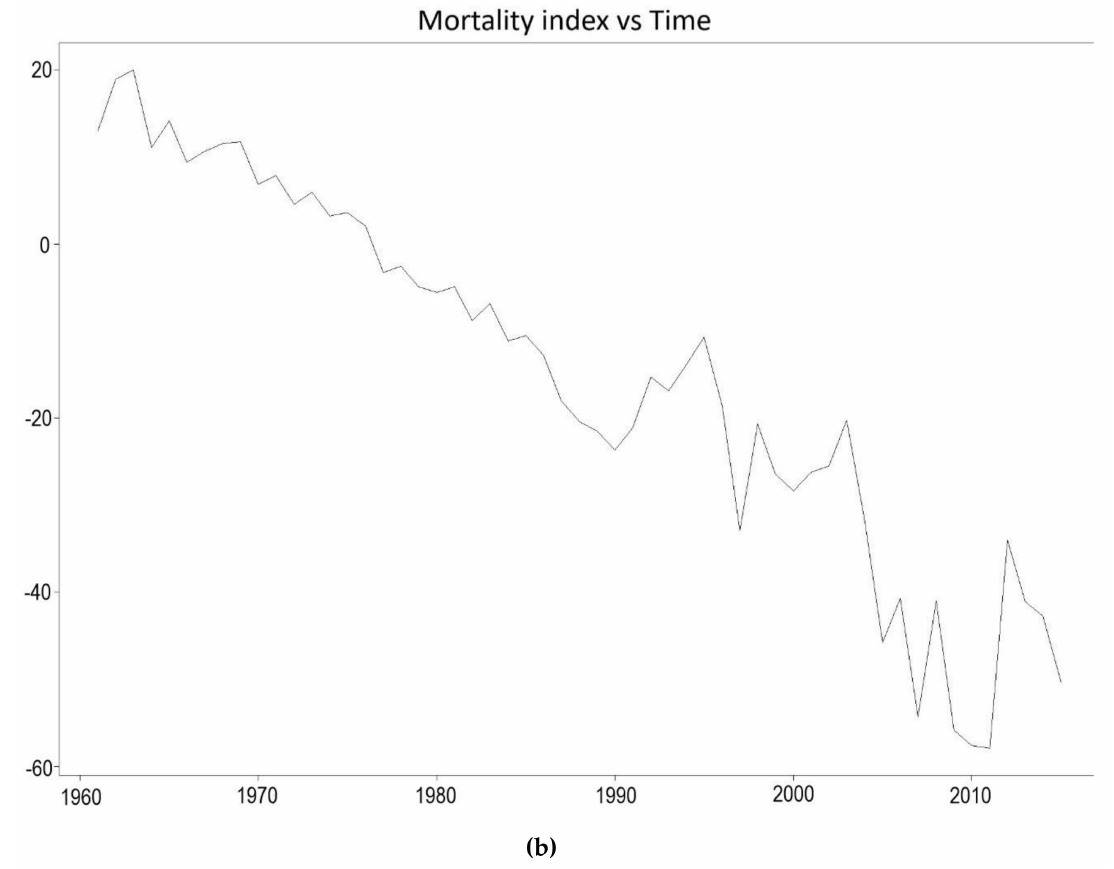
Figure 18. Forecasts of the Lee-Carter mortality index using the Kou model for the ( a ) 1939–1960 period and ( b ) 1991–2015